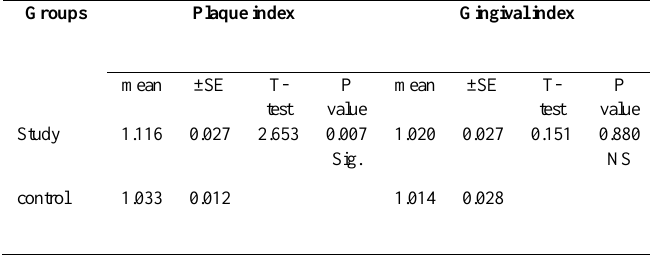
Table 2 : Mean values and statistical difference of Plaque index and Gingival index